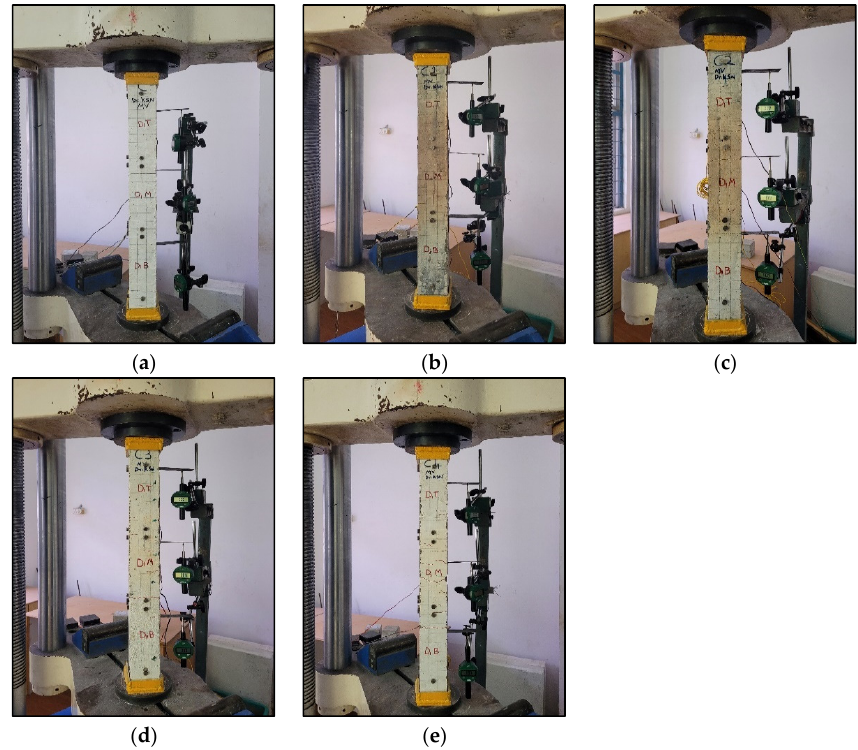
Figure 32. Entire test setup of specimens ( a ) C, ( b ) C1, ( c ) C2, ( d ) C3, and ( e ) C4. The deformation of the column was observed at the top, middle, and bottom regions and was plotted against the load. The load versus deformation profile of the top, middle, and bottom regions are exhibited in Figure 33. The crack pattern was noticed after the ultimate load. The crack patterns of the specimens after testing are exhibited in Figure 34.